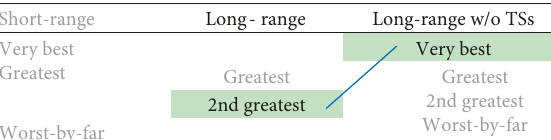
Table 12: Tabular representation of Rule 3.